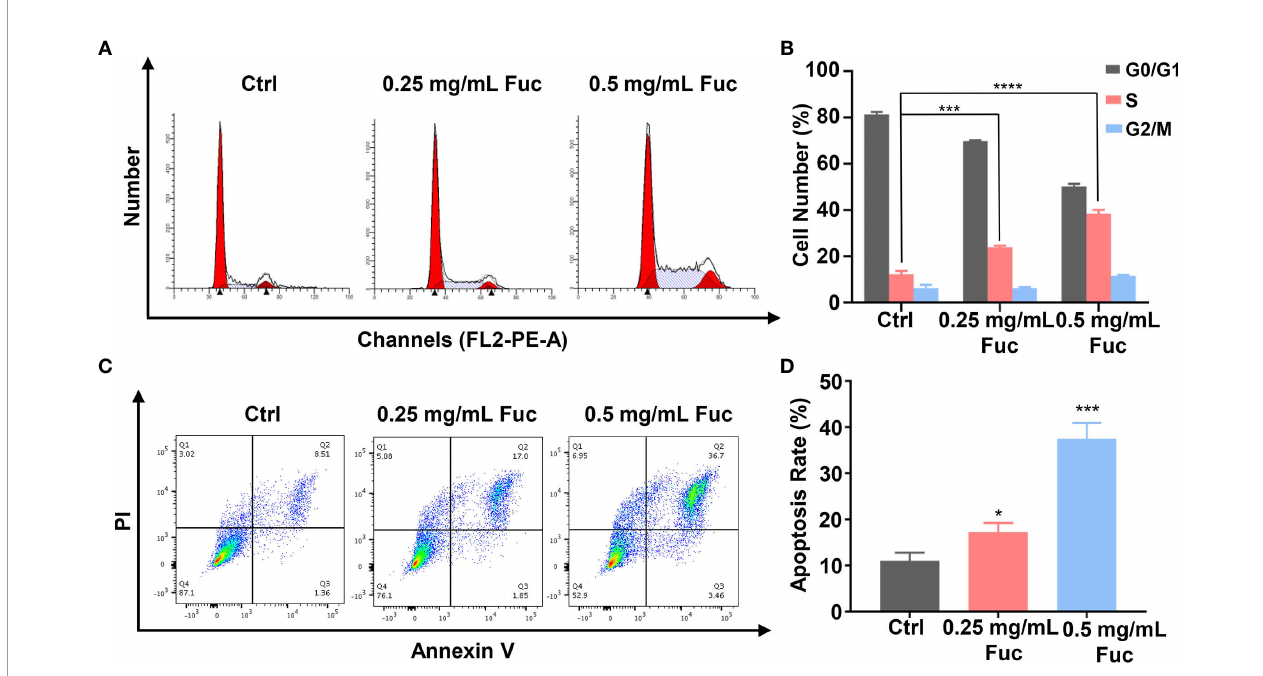
FIGURE 4 | Fucoidan arrests cell cycle and promotes apoptosis of MHCC-97H cells. (A, B) Cell cycle distribution was measured by fl ow cytometry in MHCC-97H cells induced by saline (Ctrl), 0.25 and 0.5 mg/mL Fuc. *** means P < 0.001, **** means P < 0.0001. (C, D) Percentage of apoptotic MHCC-97H cells after treatment with saline (Ctrl), 0.25 and 0.5 mg/mL Fuc. Q1 represents death cells, Q2 represents the late apoptosis cells, Q3 represents the ealry apoptosis cells, Q4 represents the normal cells. The apoptosis rate equals to the rate of late apoptosis cells (Q2) plus the rate of early apoptosis cells (Q3). * means P < 0.05, *** means P <